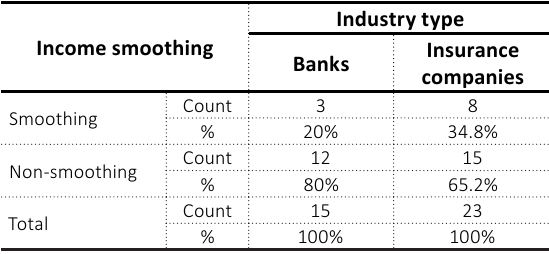
Table 4. Income smoothing by industry